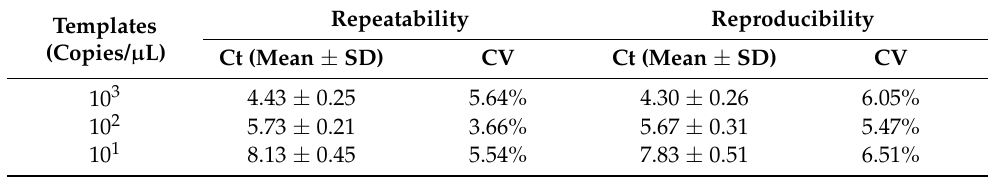
Table 2. Repeatability and reproducibility of RF-RT-RAA for PRRSV-2 detection.